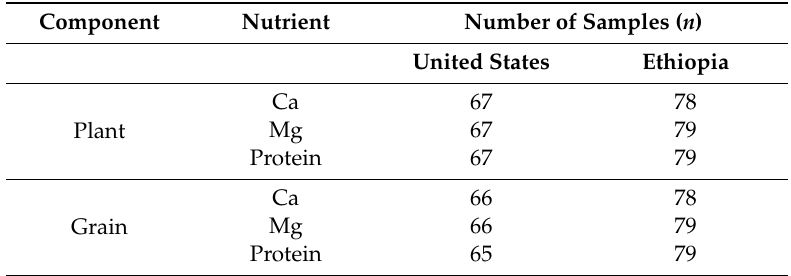
Table 1. Number of samples of each component collected in each study location.